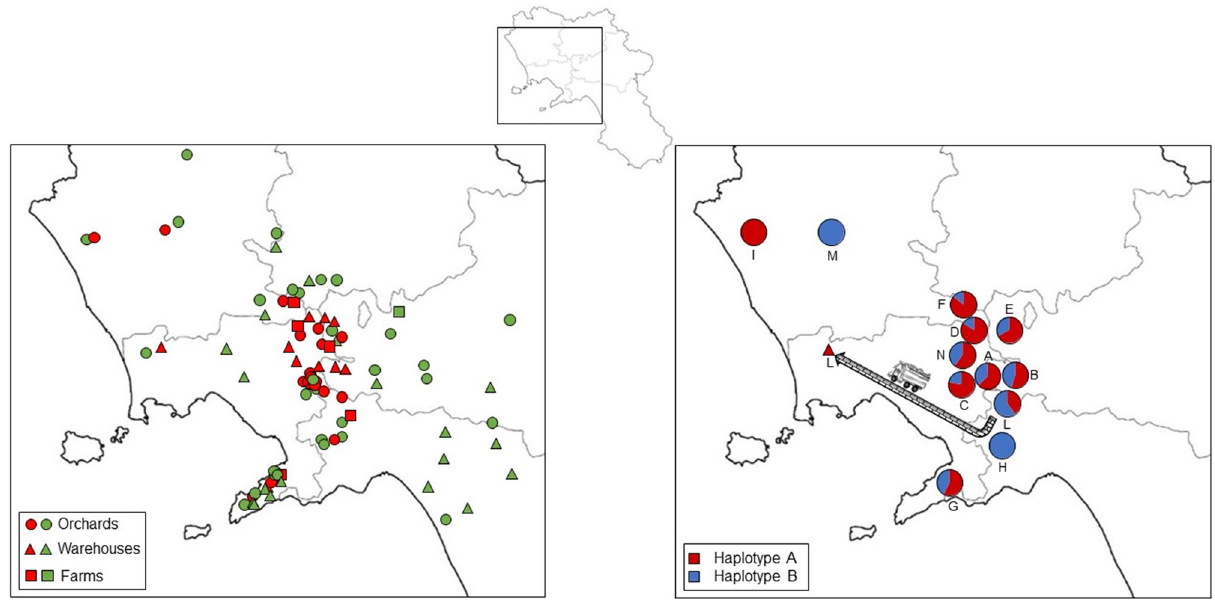
Figure 4. Survey area of monitoring activities in 2019–2020. On the left: position and types of sites where walnut fruits were sampled; infested sites (red) and uninfested sites (green). On the right: distribution and frequency of haplotypes; each circle represents an area of 3 km 2 which includes multiple infested